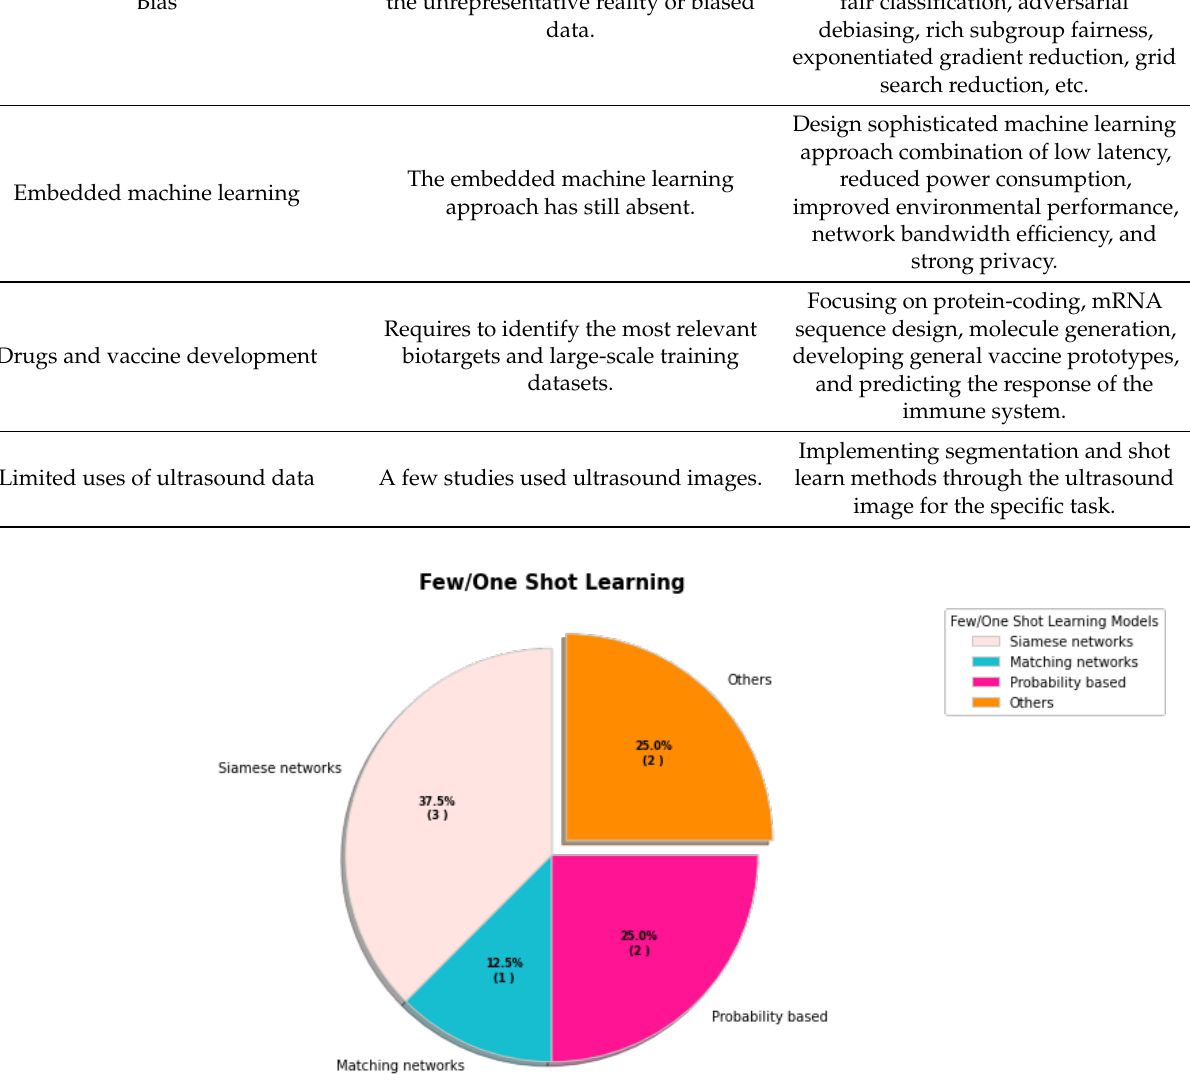
Figure 8. The percentage of shot learning models used for